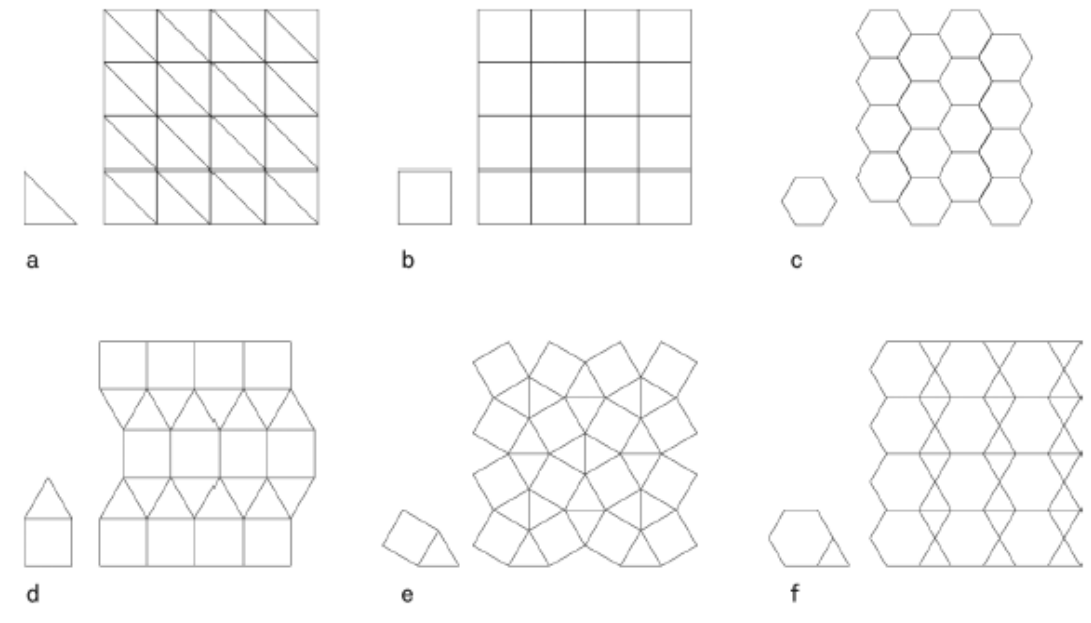
Figure 2. Examples of different shapes and organizations that could be presented on kinetic facades (Source: Rossi, Nagy & Schlueter, 2012).